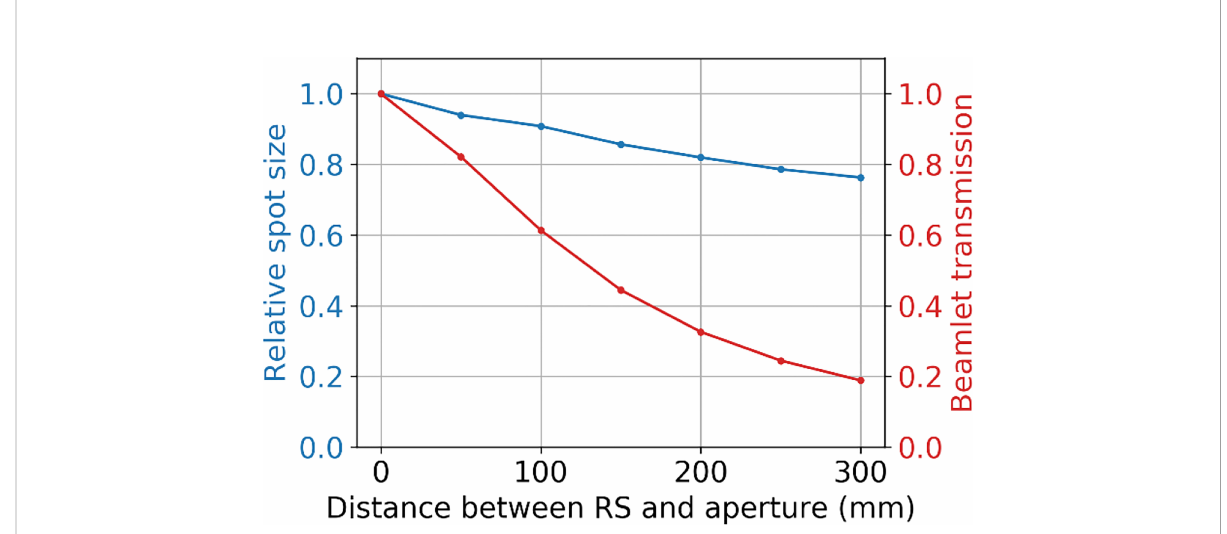
FIGURE 11 The relative spot size at the BP depth (50 mm) and beamlet transmission as a function of the separation distance between the range shifter and the aperture, where the tungsten aperture with a 3 mm radius aperture opening is at 50 mm from the water phantom